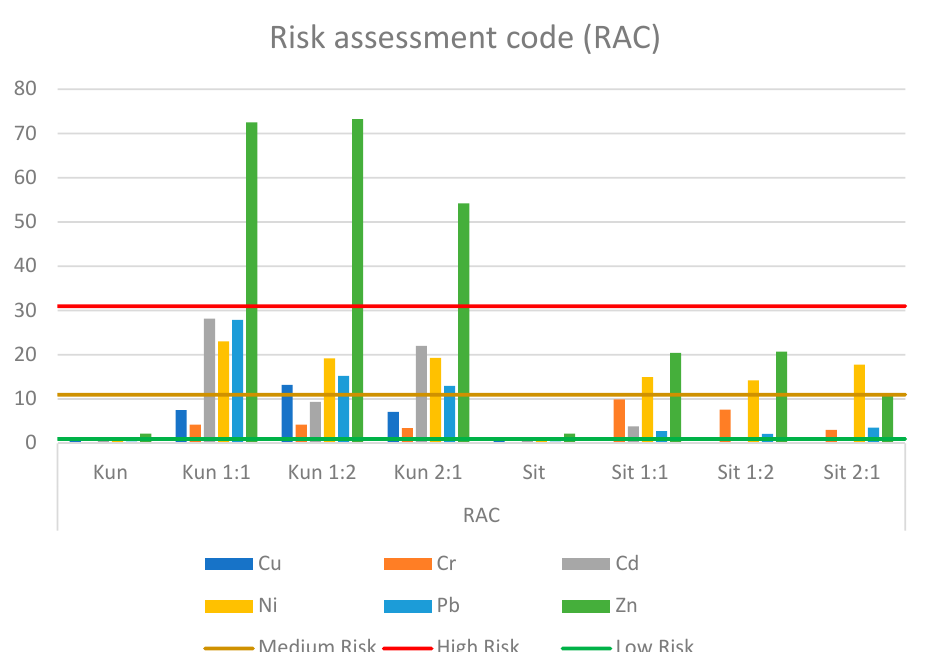
Figure 10. Value of RAC index in sludge–soil mixtures.